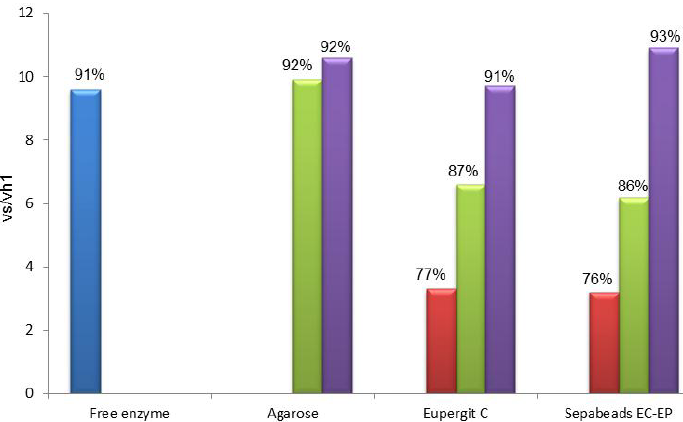
Figure 1. Selectivity of the PGA biocatalysts between the N -acylation reaction (vs) of 7-ACA and the hydrolysis of R -( − )-methyl mandelic ester (vh